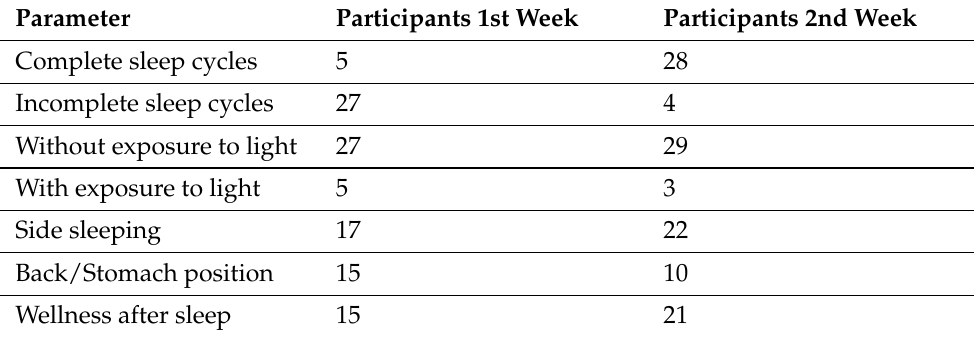
Table 3. Qualitative approach